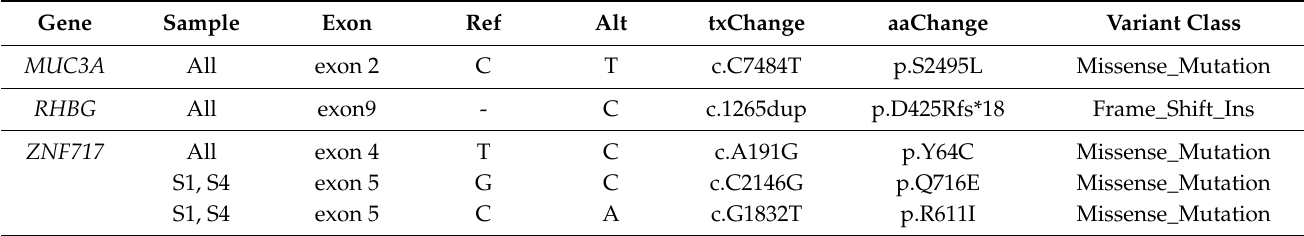
Table 2. Mutations in genes MUC3A, RHBG, and ZNF717